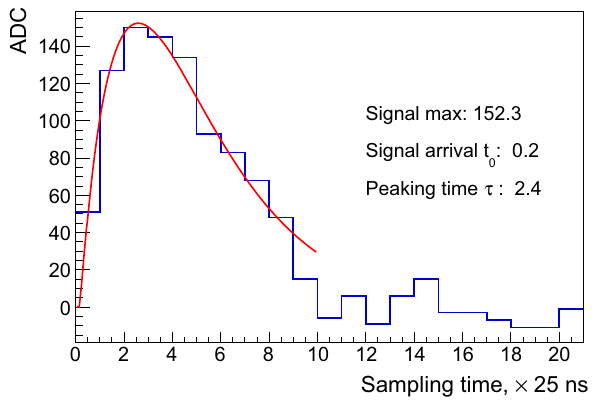
Fig. 9 Signal distribution in a single pad of the tracking layer. Green line – after zero suppression, blue line – after additional selection cri- teria, and red line – fit with a convolution of Landau and Gaussian distribution functions